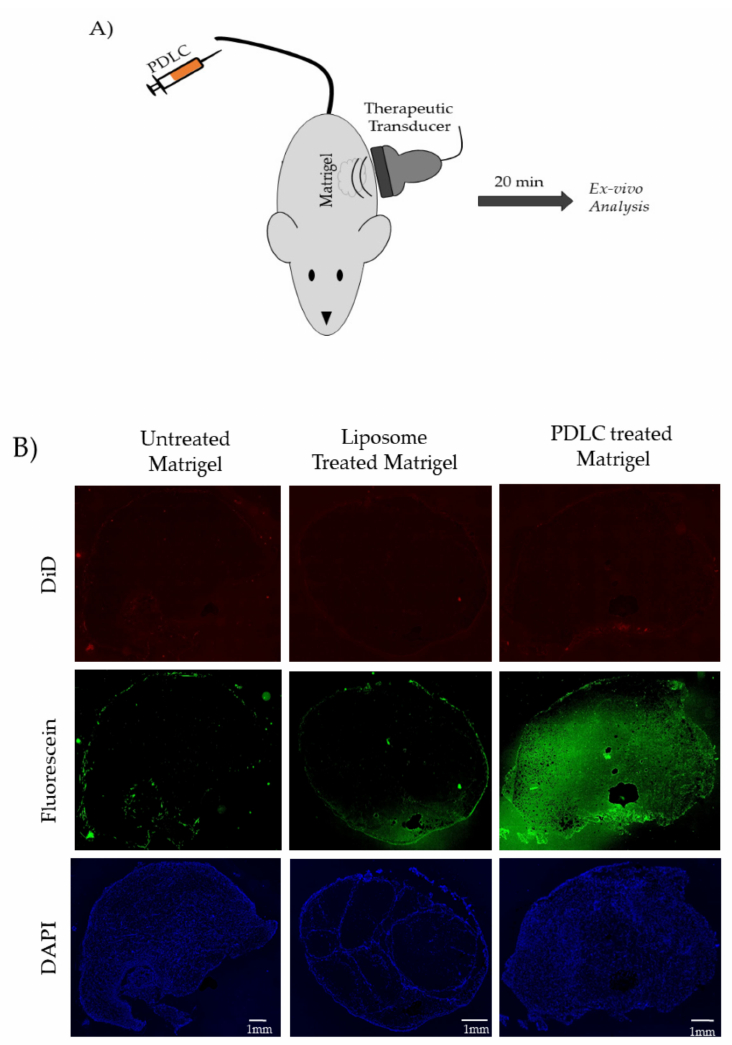
Figure 10. ( A ) Experimental setup for vaporizing PDLCs and trigger fluorescein uncaging ( B ) DAPI (cell nuclei), Fluorescein (model drug), and DiD (droplet shell) channels show the effect of uncaging and fluorescein delivery to Matrigel™ plugs. All scale bars show 1